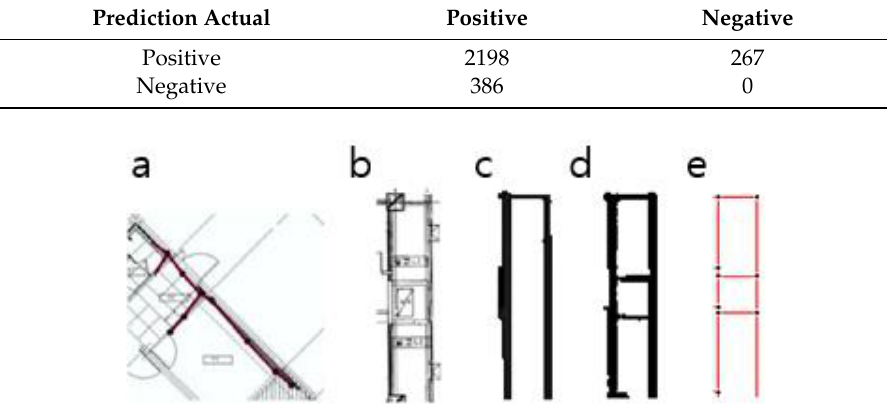
Figure 9. Wrong Prediction: ( a ) floorplan with diagonal wall; ( b ) original floorplan with furnishing; ( c ) ground truth pixel; ( d ) prediction pixel; ( e ) generated vector.